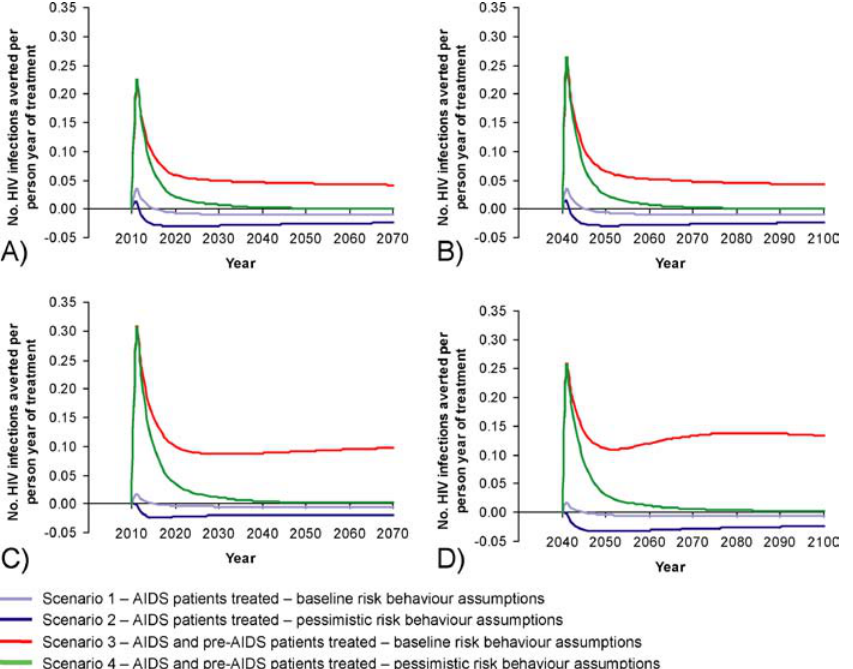
Figure 3. Total Number of HIV Infections Averted per Person-Year of Treatment for Various HIV Epidemics and under Different Assumptions regarding Behaviour Change of Treated Patients Scenarios as for Figure 2. DOI: 10.1371/journal.pmed.0030124.g003